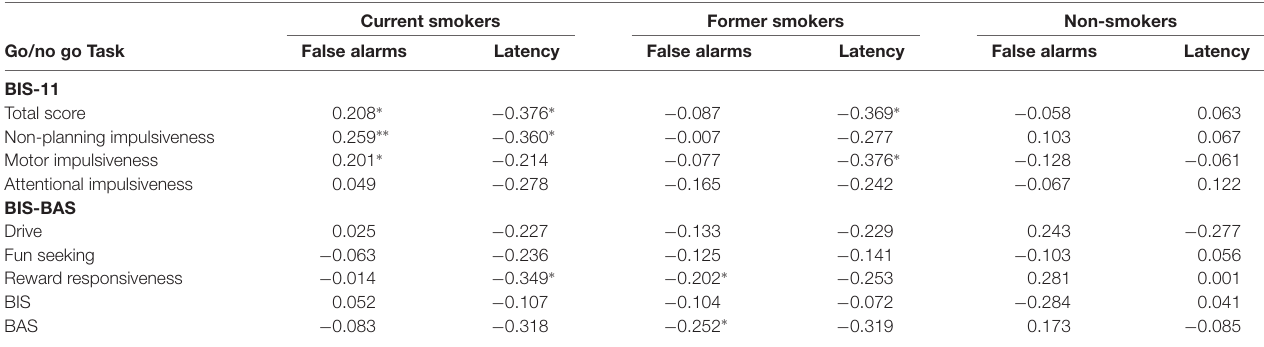
TABLE 4 | Correlations coefficient between BIS-11, BIS/BAS and response latency and the number of false alarms in Go/no Go